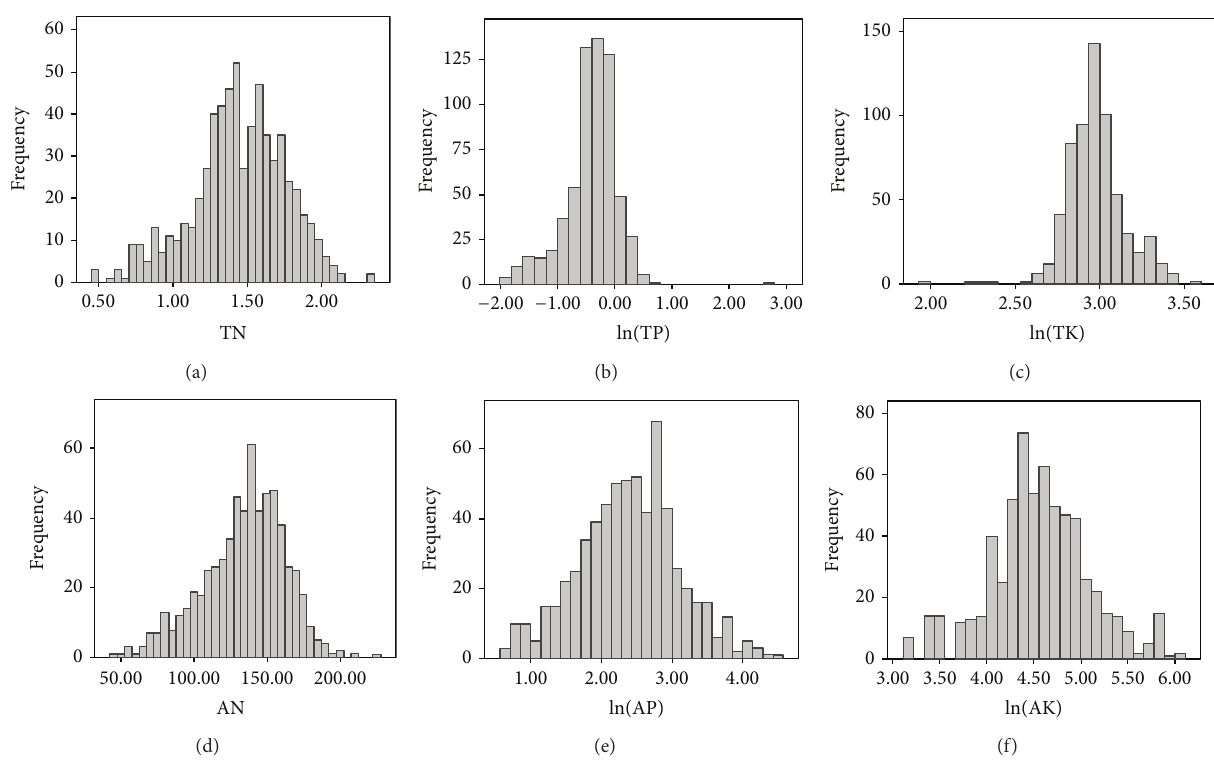
Figure 2: Histograms of TN (a), ln ( TP ) (b), ln ( TK ) (c), AN (d), ln ( AP ) (e), and ln ( AK ) (f).